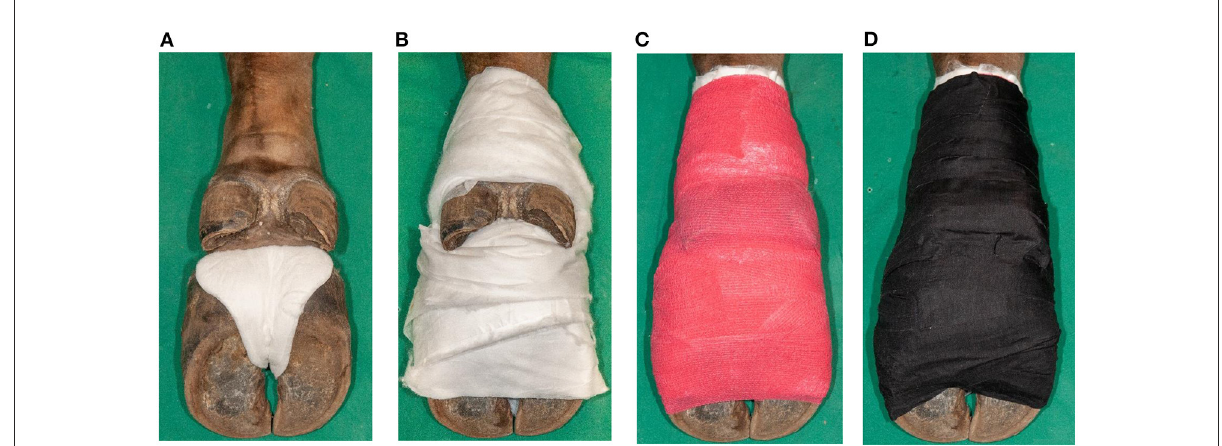
FIGURE1 Application of a firm bandage after salicylic acid paste (Novaderma ad us. vet., Paste, Streuli Tiergesundheit AG, Switzerland) treatment of digital dermatitis lesions in European bison ( Bison bonasus ). (A) Padding of interdigital cleft with a water-repellent, ergonomic compress (ITIN + HOCH GmbH, Switzerland) (B) followed by padding of the skin from the claws until above the dewclaws with omission of the interdigital cleft and dewclaws with absorbent cotton (Kistler cotton with fleece, Covetrus AG, Switzerland). (C) Fixation with cohesive tape (cohesive bandages, Covetrus AG, Switzerland) in eight-shaped loops, integrating the interdigital cleft, and in a circular way up until above the dewclaws. (D) Double wrapping of the foot including the interdigital cleft with adhesive tape (Tesa 4688, Covetrus AG, Switzerland) to guarantee water-repellent